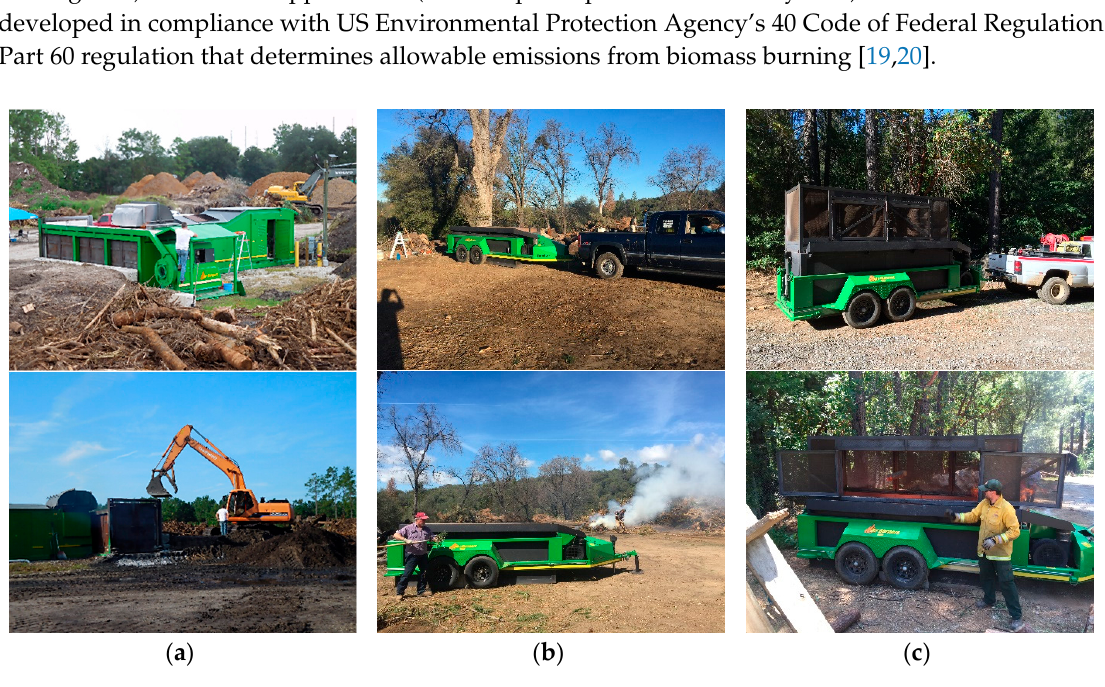
Figure 1. The Air Curtain Burners used to test burning of forest residues in ( a ) S-220 in Jacksonville, Florida; ( b ) BurnBoss in Groveland, California; and ( c ) BurnBoss installed with ember screen in Volcano, California. The loader is used to load the forest residues in S-220 operation while BurnBoss operation is loaded by hand.